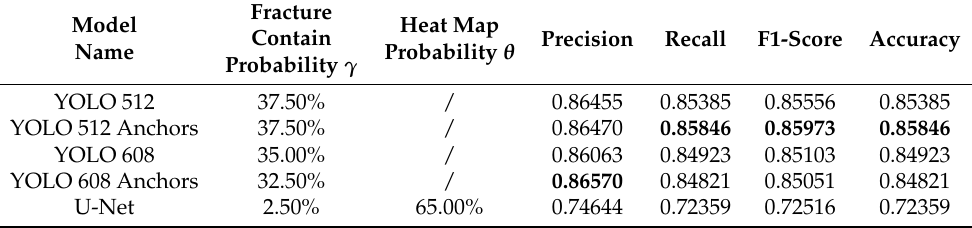
Table 3. Image-based evaluation of the models on test set #1. Model